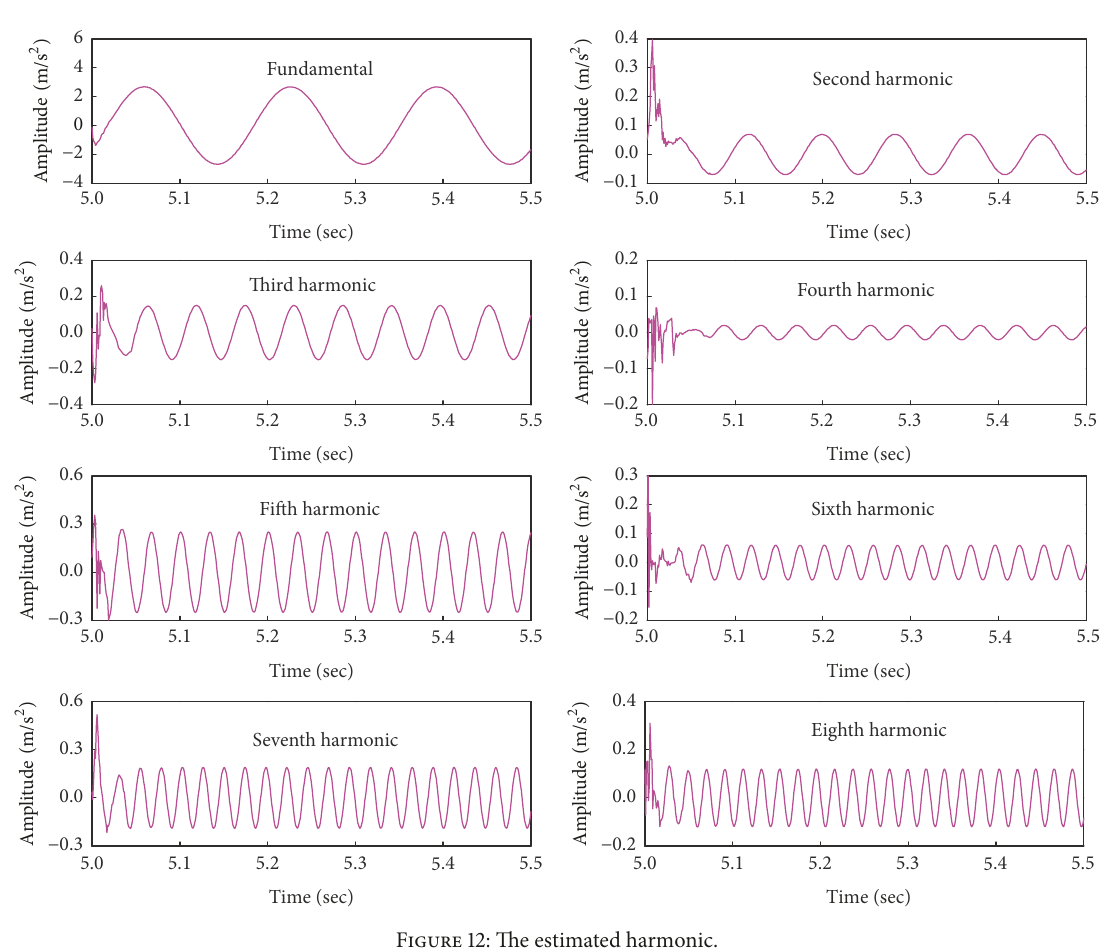
Figure 12: The estimated harmonic.